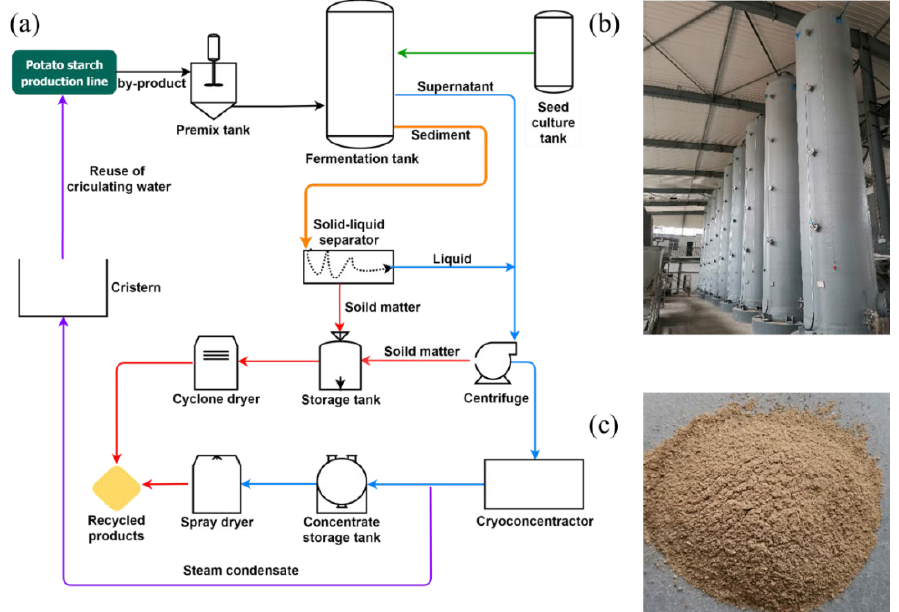
Figure 1. ( a ) Industrial reutilization biotechnology of potato starch by-products from a plant with an annual output of 1000 tons of starch and composed of three parts: Microbial fermentation production line, Solid-liquid separation production line, Drying and recovery production line. ( b ) Real photo of Microbial fermentation production line in the factory. ( c ) Recycled